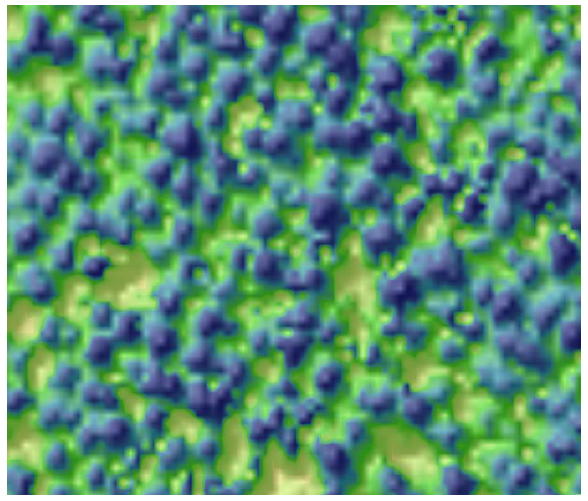
Figure 8. The resulting CHM of the pit-free algorithm